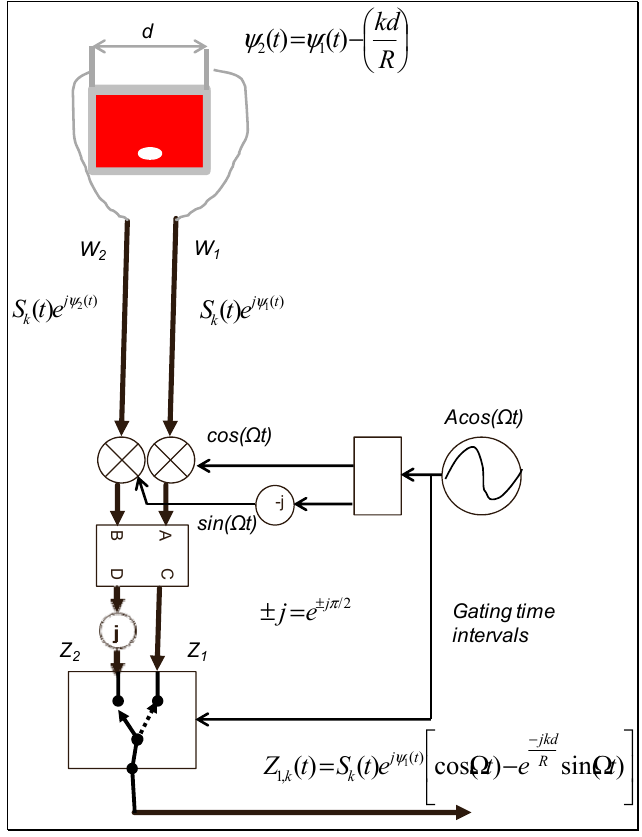
Figure 6. An alternative implementation of pseudo-Doppler OAM receiving front end.